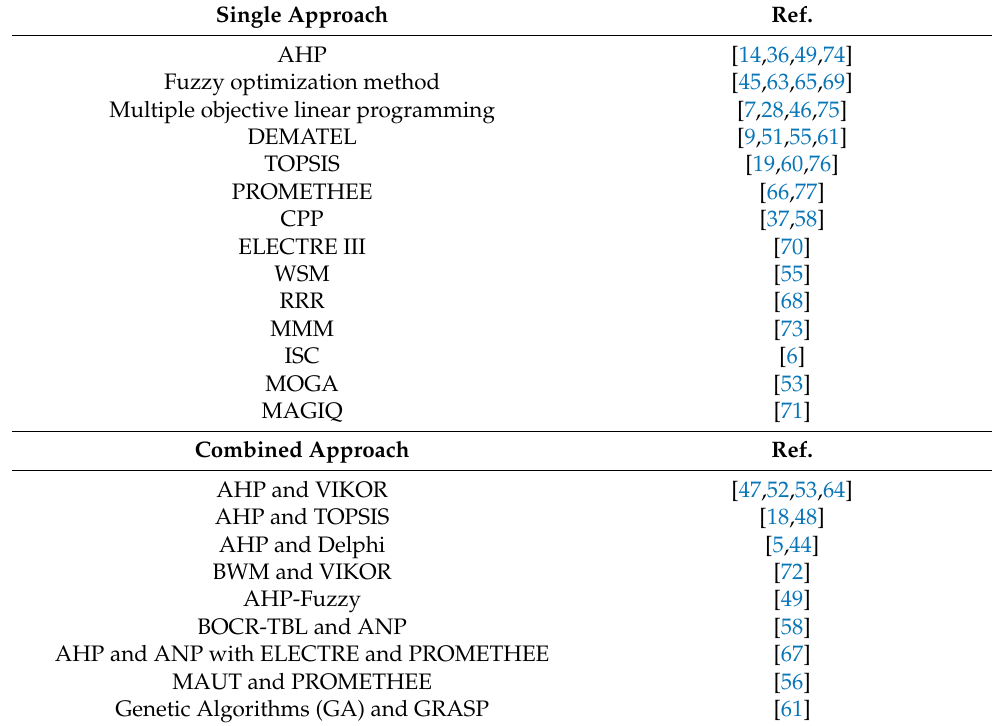
Table 6. MCDM approach